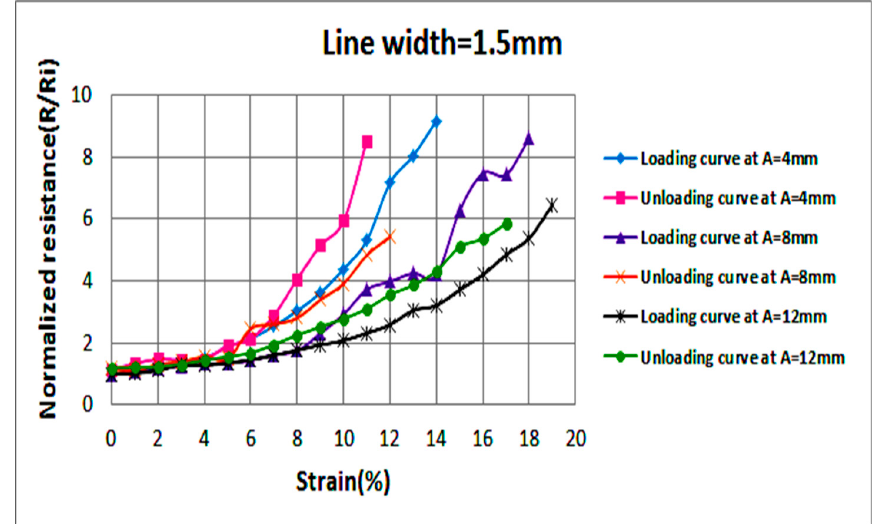
Figure 9. Average normalized resistances of two sinusoidal samples at a line width of 1.2 mm and various amplitudes as the applied strain increases (loading) and decreases (unloading). Sensors 2018 , 18 , x FOR PEER REVIEW